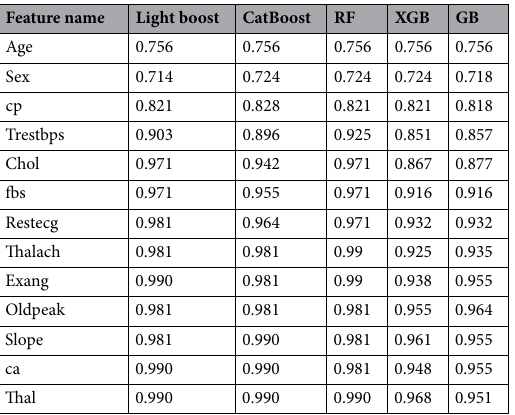
Table 7. Importance of features of the dataset.